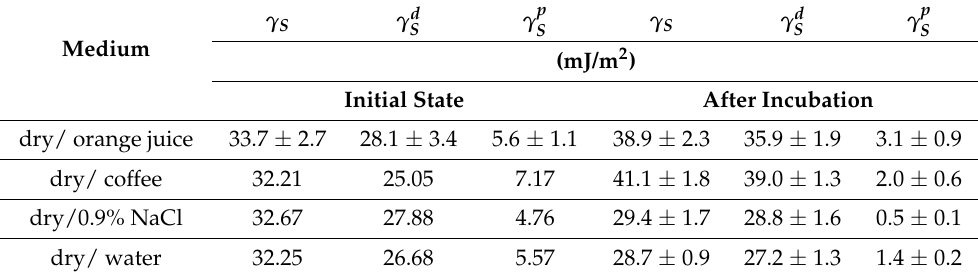
Table 5. The influence of medium type on the values of SFE and its components according to the Owens–Wendt model for dental